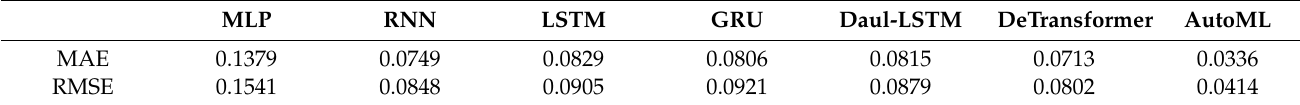
Table 5. Comparison of prediction results of AutoML with other ML